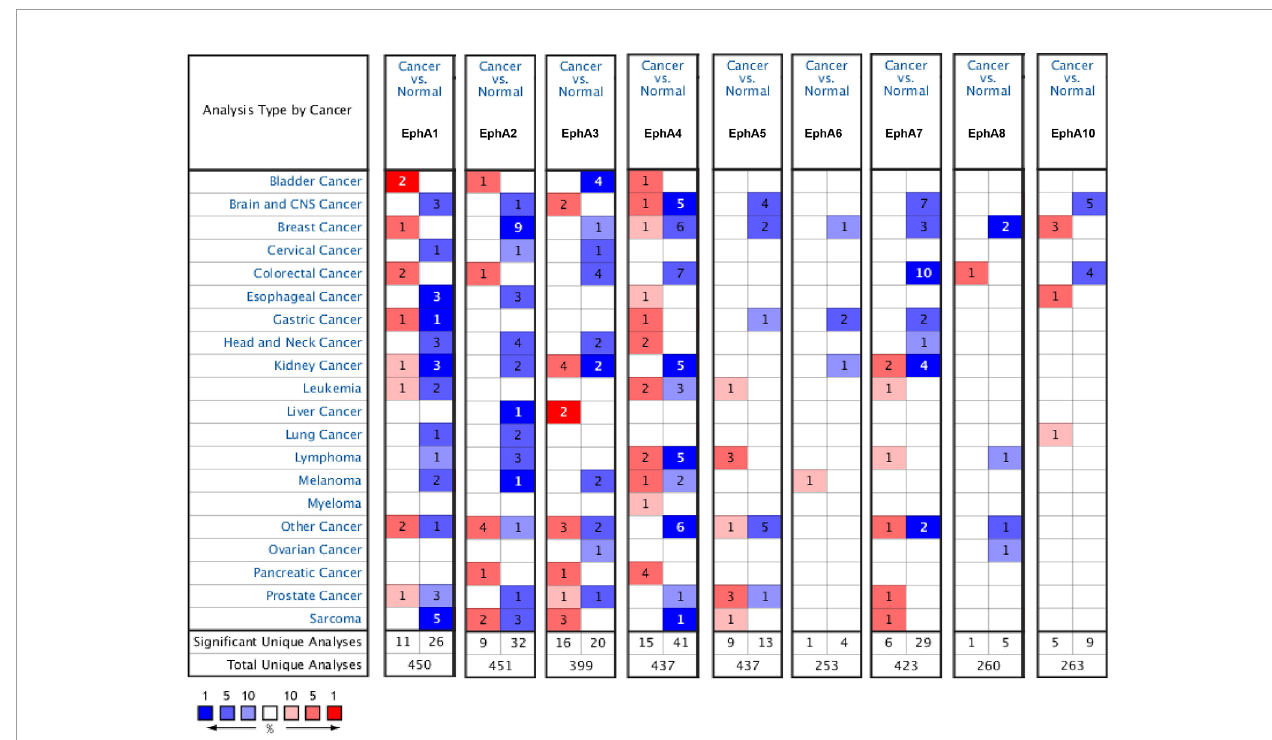
FIGURE 1 | The mRNA expression pattern of EphA family members in different tumor types. The graphs generated from the Oncomine database show the numbers of data sets with statistically signi fi cant expression of EphA family in different types of tumor tissues and normal tissues. High expressions were showed in red block charts, and low expressions were shown in blue block charts. The threshold was de fi ned with the following parameters: P -value of 0.01, fold change of 2 and gene ranking of top 10%. Cell color is determined by the best gene rank percentile for the analyses within the